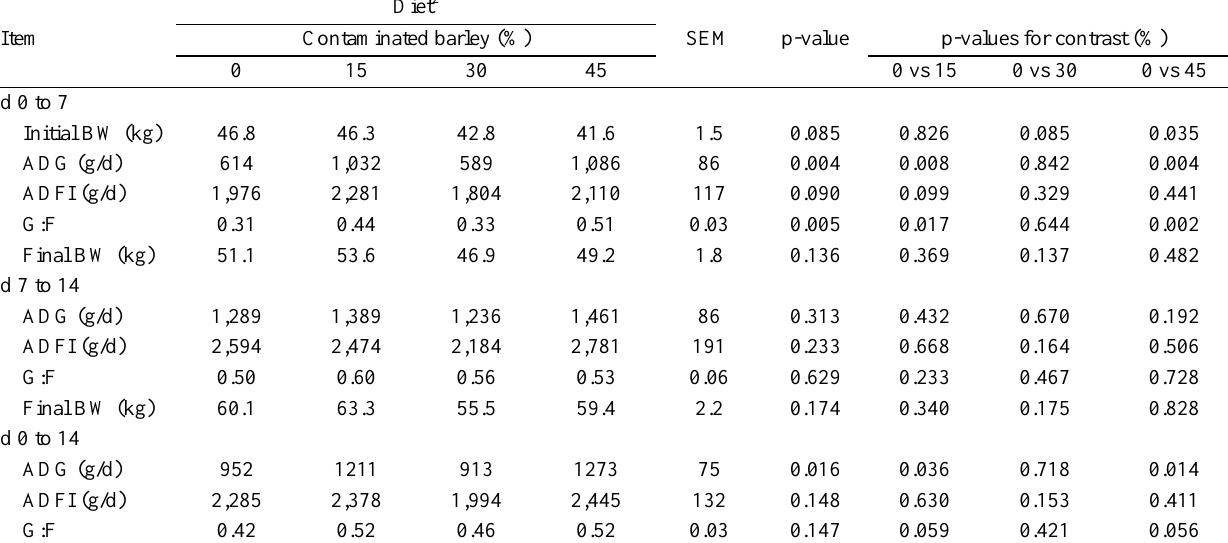
Table 8. Growth performance of pigs fed the recovery diet 1 , Exp.